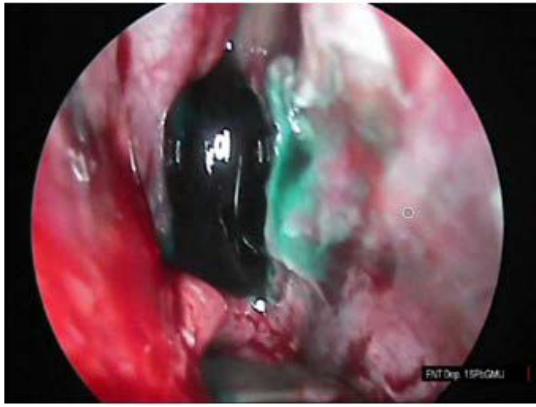
Figure 4. Sphenoid sinus filled with methylene blue solution.